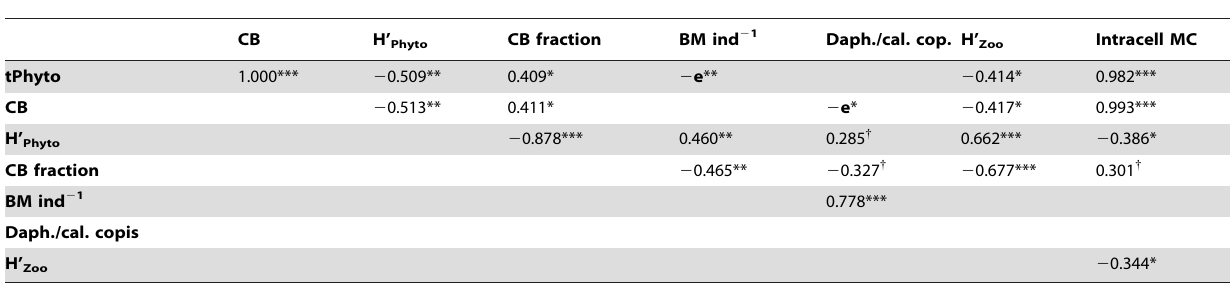
Results of Pearson’s and exponential correlations between parameters describing the zooplankton and primary producer communities. ***=p , 0.001; **=p , 0.01; *=p , 0.05; { =p , 0.1; 2 e =significant negative exponential correlation (see results section for equations). tPhyto=total phytoplankton biomass ( m g chl- a L 2 1 ),